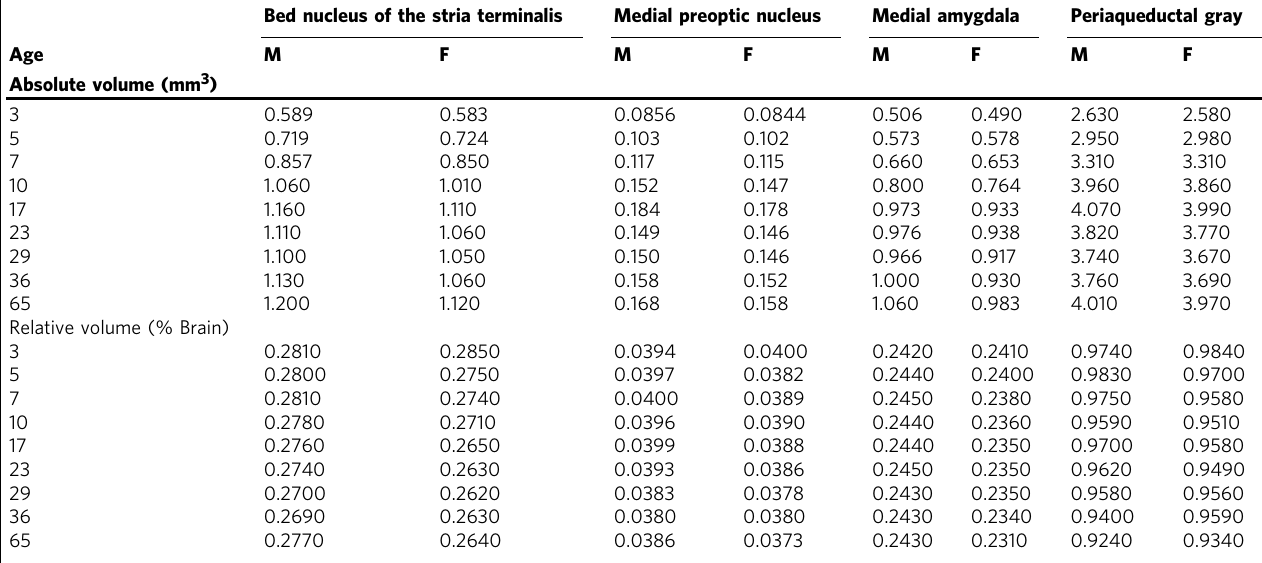
Table 1 Mean volume of sexually dimorphic structures in males and females Bed nucleus of the stria terminalis Medial preoptic